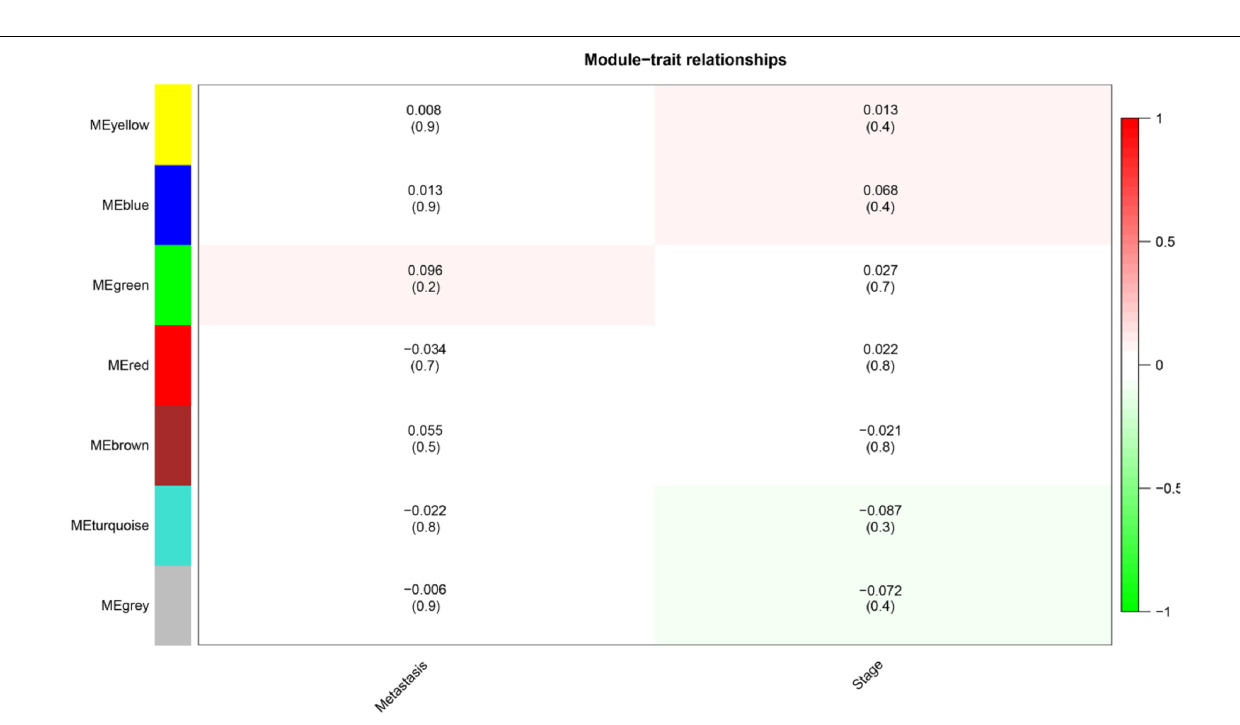
Frontiers in Genetics |